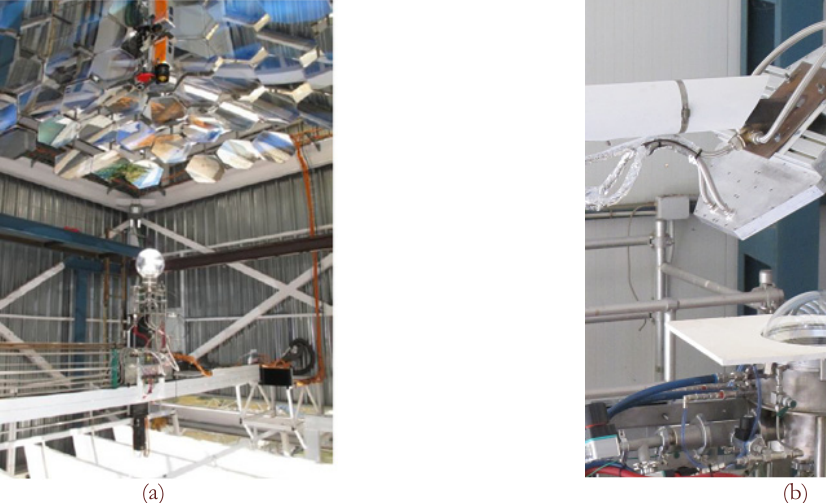
Figure 2: Examples of glass components of CSP systems at PSA-CIEMAT. a) Aspect of the solar concentrator and reaction chamber of SF-5 solar furnace; b) Aspect of the MiniVac chamber installed at the focal spot of the new SF-40 solar furnace; a 45º inclined mirror above the MiniVac allows the sunrays to reflect